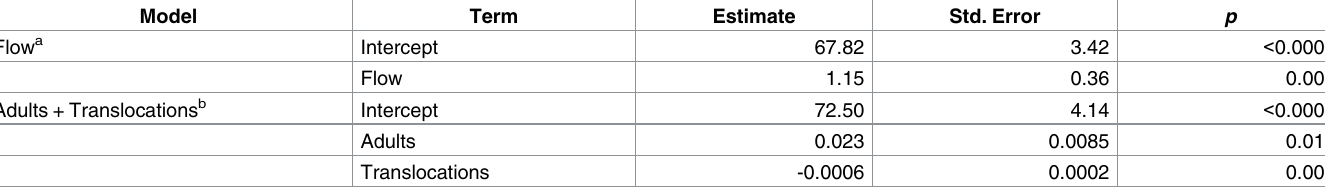
Table 6. Coefficients for best models of YOY length in October.